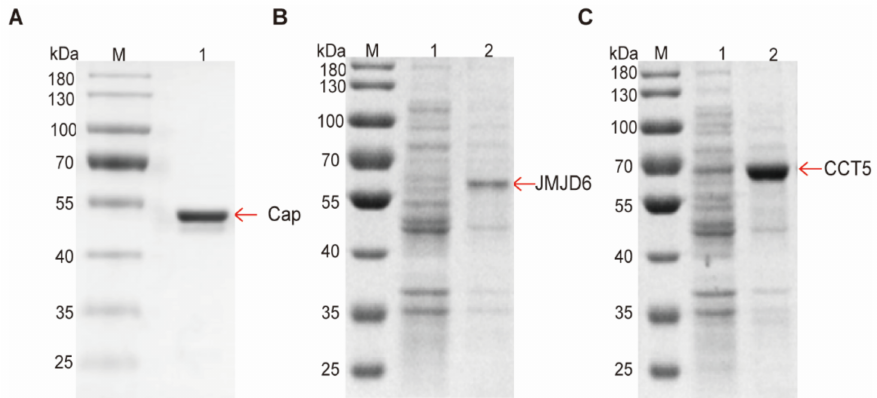
Figure 5. Expression and purification of Cap, JMJD6 and CCT5. ( A ) SDS-PAGE analysis of the purified EDA-Cap. M, protein molecular mass standards; 1, the purified EDA-PCV2 Cap. ( B ) SDS- PAGE analysis of the purified JMJD6. M, protein molecular mass standards; 1, soluble fraction after cell sonication; 2, the purified JMJD6. ( C ) SDS-PAGE analysis of the purified CCT5. M, protein molecular mass standards; 1, soluble fraction after cell sonication; 2, the purified